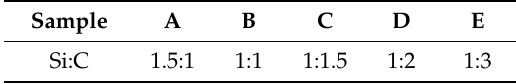
Table 1. The silicon-carbon ratio of each batch (molar ratio).